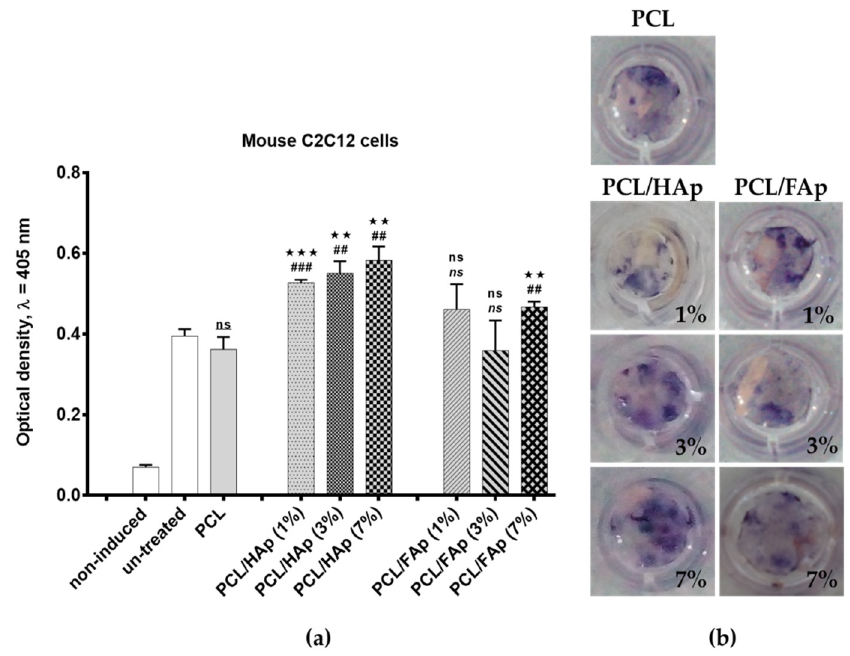
Figure 5. Early BMP2/7-induced osteoblast differentiation of C2C12 cells evaluated on ALP activity after 4 days of culturing on pure PCL and PCL scaffolds containing 1%, 3% and 7% of HAp or FAp. Data of ( a ) spectrophotometric measurement of ALP activity are presented as mean ± SD ( n = 3); p -values were calculated based on t -test. Asterisks show the significance levels of difference for particular variants versus controls: **(##) for p < 0.01; ***(###) for p < 0.001; ns (ns, ns)—non-significant. Notes: *—particular variants versus cells cultured on pure PCL scaffold; #—particular variants versus cells cultured without scaffold; ns—particular variants versus cells cultured on pure PCL scaffold; ns—particular variants versus cells cultured without scaffold; ns—cells cultured on pure PCL scaffold versus cells cultured without scaffold. Representative fields of ( b ) histochemical staining of extracellular ALP is shown at 1× magnification.